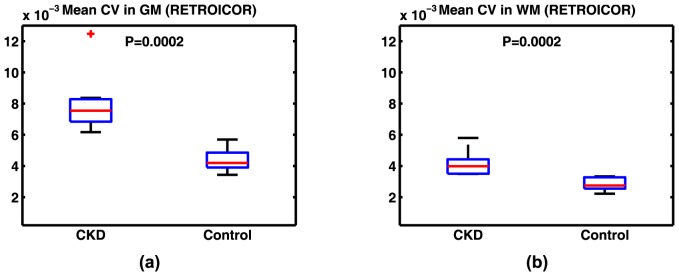
Mean CV of signal fluctuations in (a) GM and (b) WM for young healthy control and CKD populations after applying RETROICOR.Results are not significantly different from those achieved without RETROICOR (Figure 3c–d).